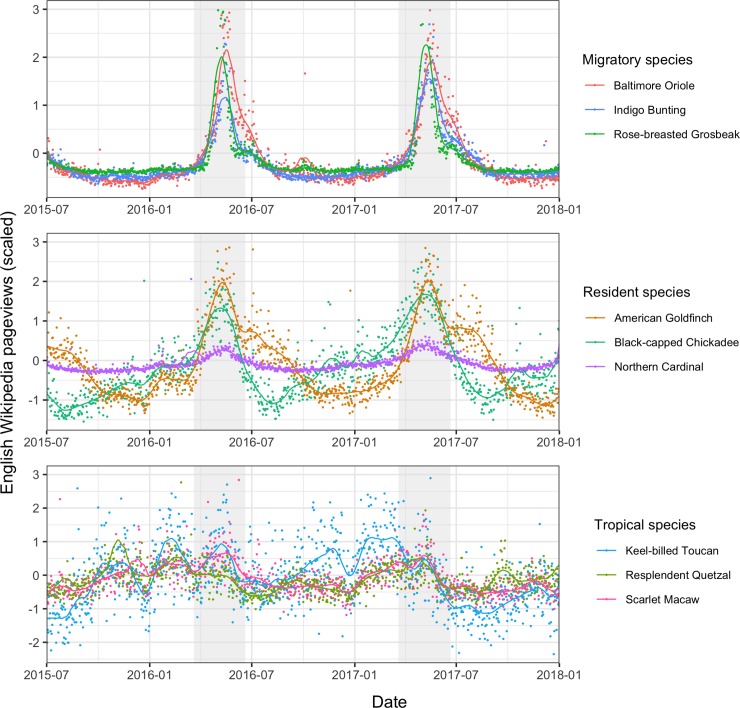
Daily pageviews in English-language Wikipedia for nine bird species.Pageviews for three migratory birds (top panel) show a strong seasonal peak coinciding with the bird’s arrival on breeding grounds in the United States. Pageviews for three North American resident birds show more variable patterns (second panel), and pageviews for three tropical species (bottom panel) that do not occur in the US show fluctuations over the course of the year but no consistent seasonality. Investigating the drivers of these patterns for individual species could be a rich area for further study, in particular as to whether changes in pageviews can be related to trends in population abundance and location or to particular human activities. Background gray shading indicates the dates of spring in the Northern Hemisphere. Pageviews for each species are scaled by subtracting the mean and dividing by the standard deviation (for data used in plots, see S1 Data).